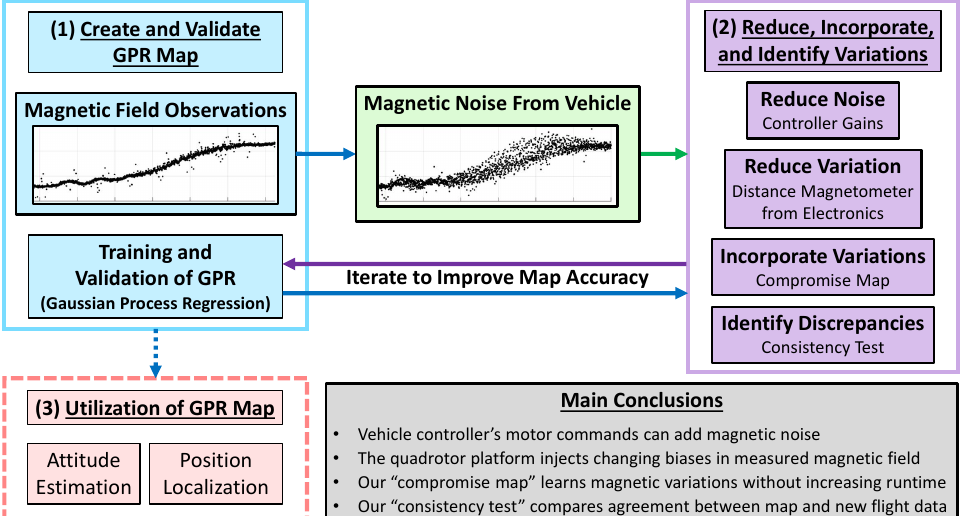
Figure 1. Methods to reduce, incorporate, and identify vehicle-induced magnetic field noise. The proposed interventions can be progressively added until the user’s map is sufficiently accurate for the